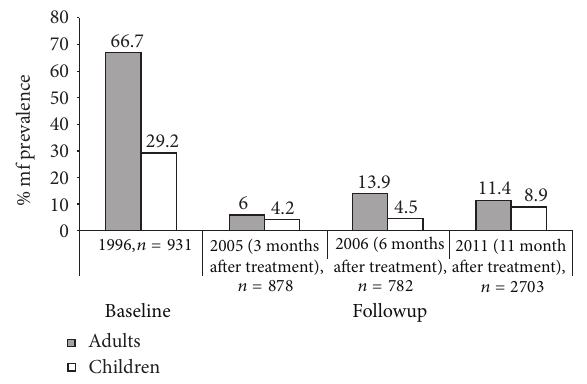
Figure 2: Comparison of mf rates among adults and children at baseline, 1996, with followup surveys in 2005, 2006, and 2011 in West Region of